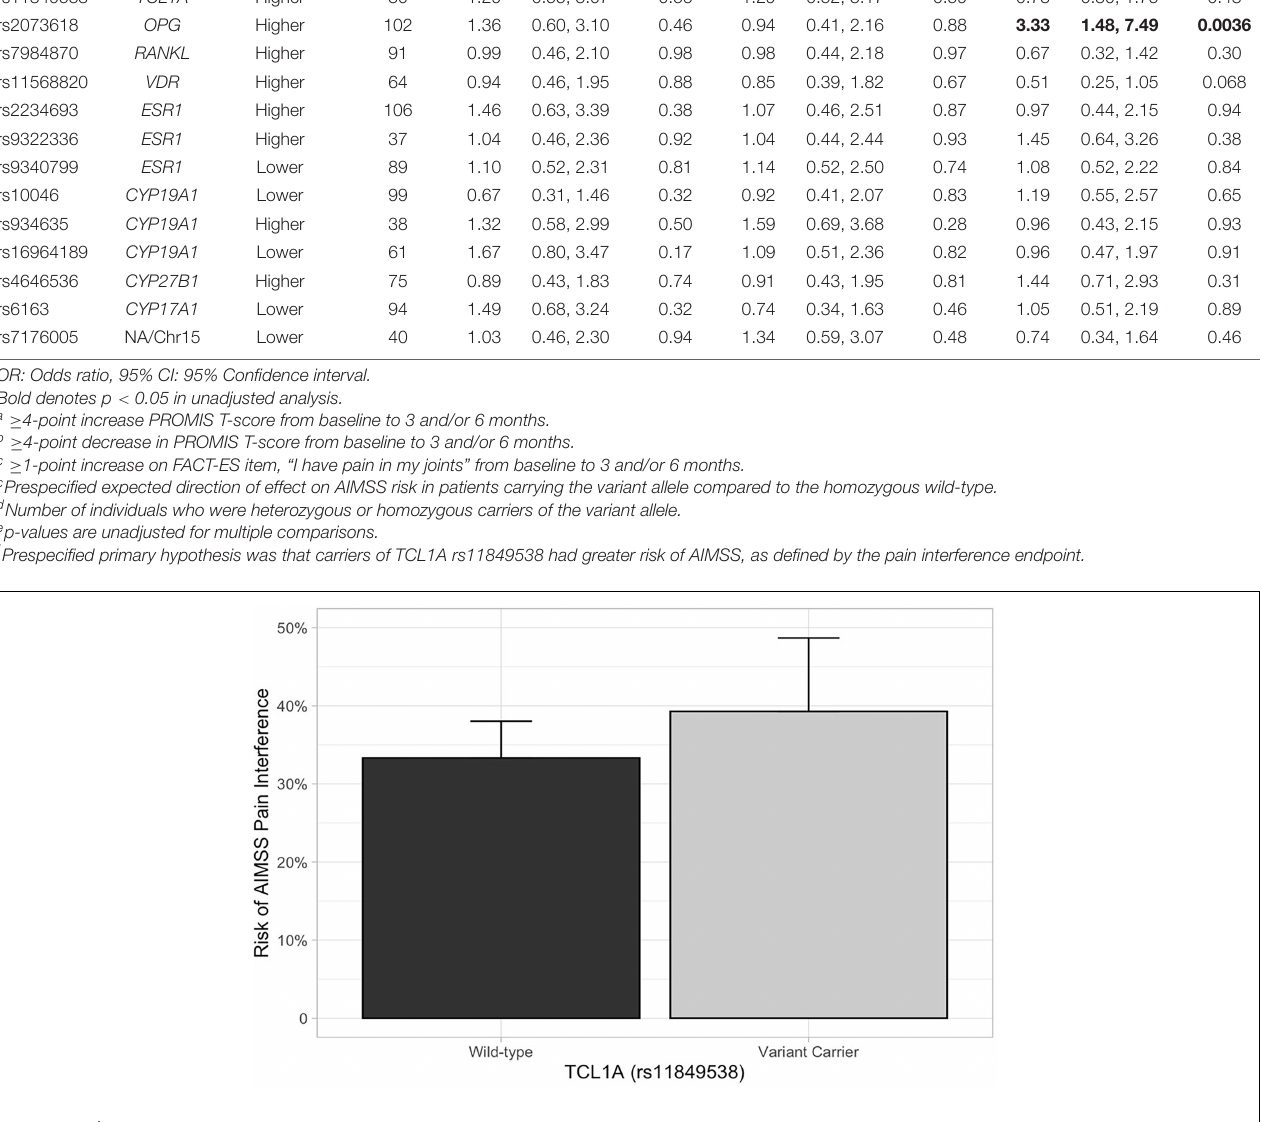
consistent with an additive or dominant genetic effect.